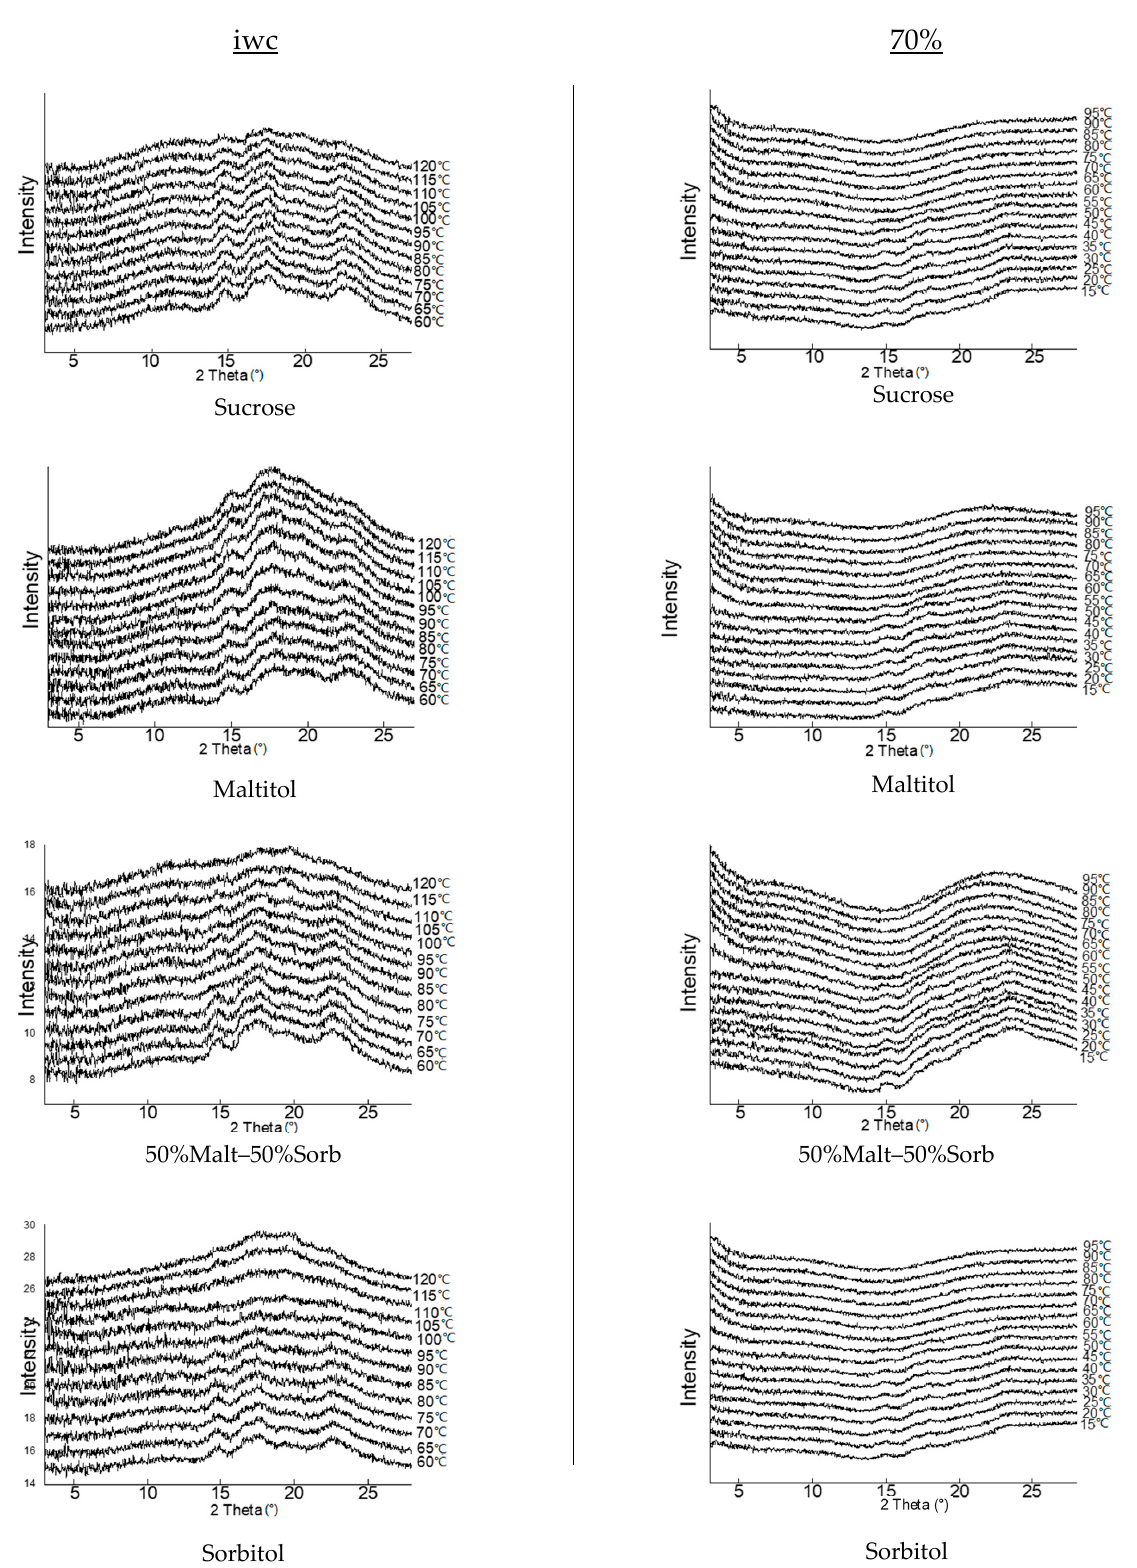
Figure 5. WAXS diffractograms of control and reformulated doughs at initial water content (iwc) and in excess water (70%) during baking kinetics from +60 ◦ C to +120 ◦ C. Diffraction patterns are offset for